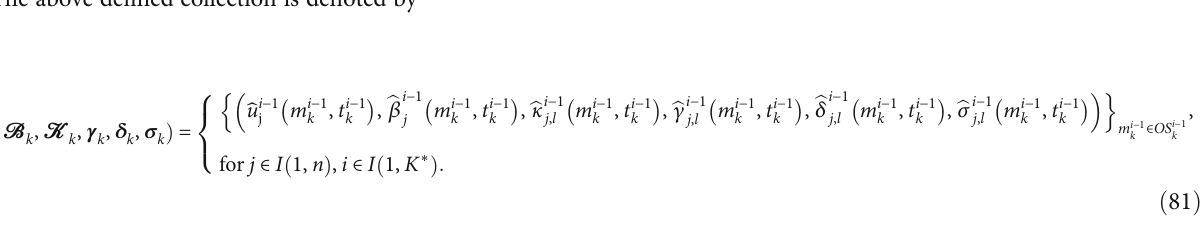
ð ̂ m , k Þ for natural gas, crude oil, and coal, k 3